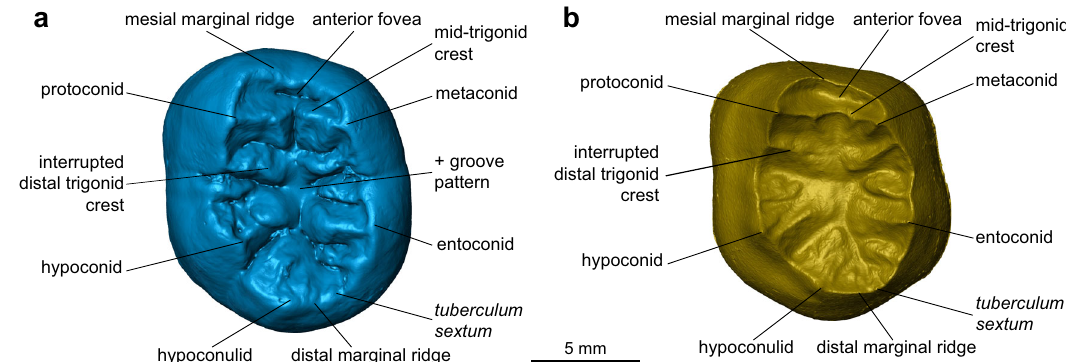
Fig. 3 Morphological features on the virtual rendering of the TNH2-1 specimen. Virtual renderings of the outer enamel surface ( a ) and enamel-dentine junction ( b ) in occlusal view showing the main morphological features.